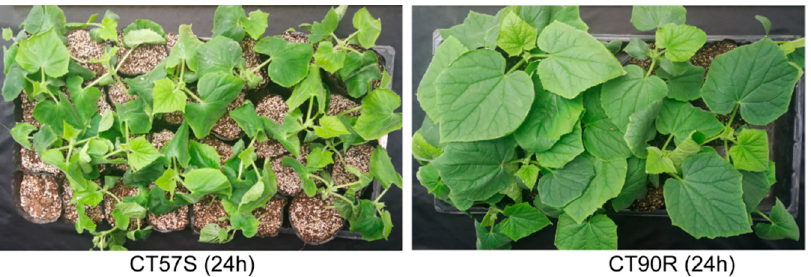
Figure 1. Symptom of chilling injury started to appear at 24 h in cold treatment. Left , the appearance of cold-sensitive CT57S. Right , the appearance of cold-tolerant CT90R.